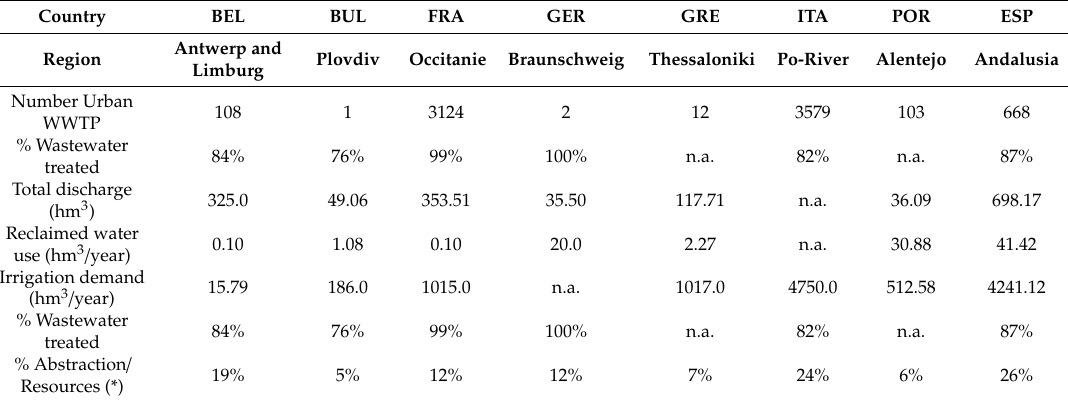
Table 1. Data insight for